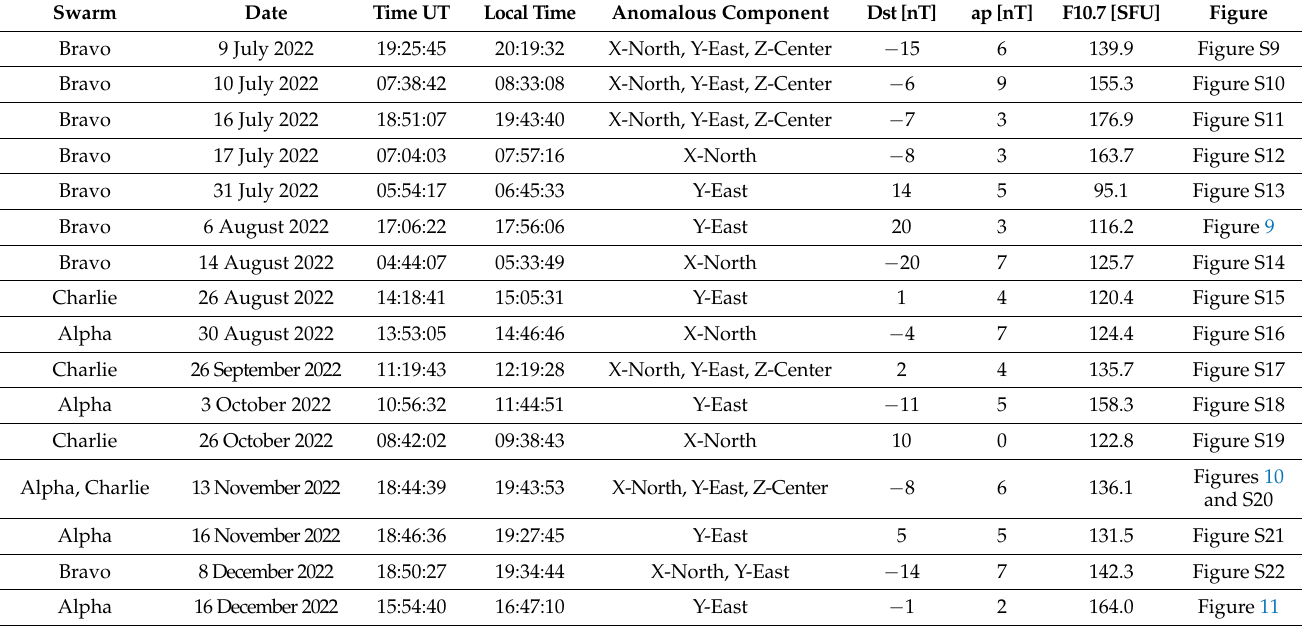
Table 3. List of the Swarm anomalous tracks in the circular research area of 235 km of radius centred on the ML3.3 Guidonia 1 January 2023